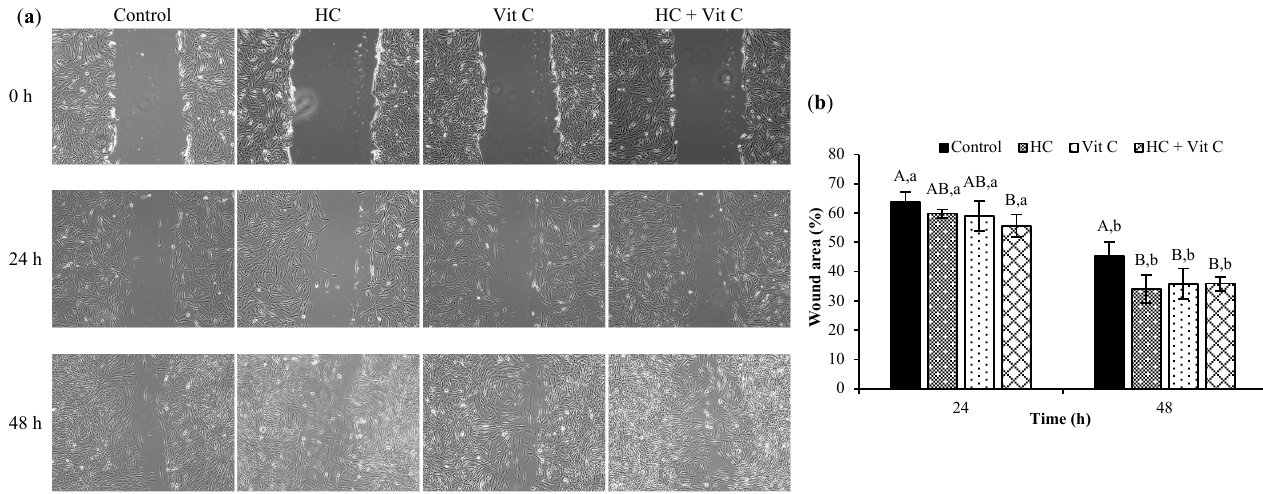
Figure 4. Effect of HC, Vit C, and HC combined with Vit C (HC+Vit C) at the selected levels on HDF migration at 0, 24, and 48 h. Cell morphology with a magnification of × 10 ( a ) and % wound area ( b ). Bars represent standard deviation ( n = 3). Different uppercase letters on bars indicate significant differences among different samples tested within the same time ( p < 0.05). Different lowercase letters on bars indicate significant differences between time tested within the same samples ( p < 0.05).